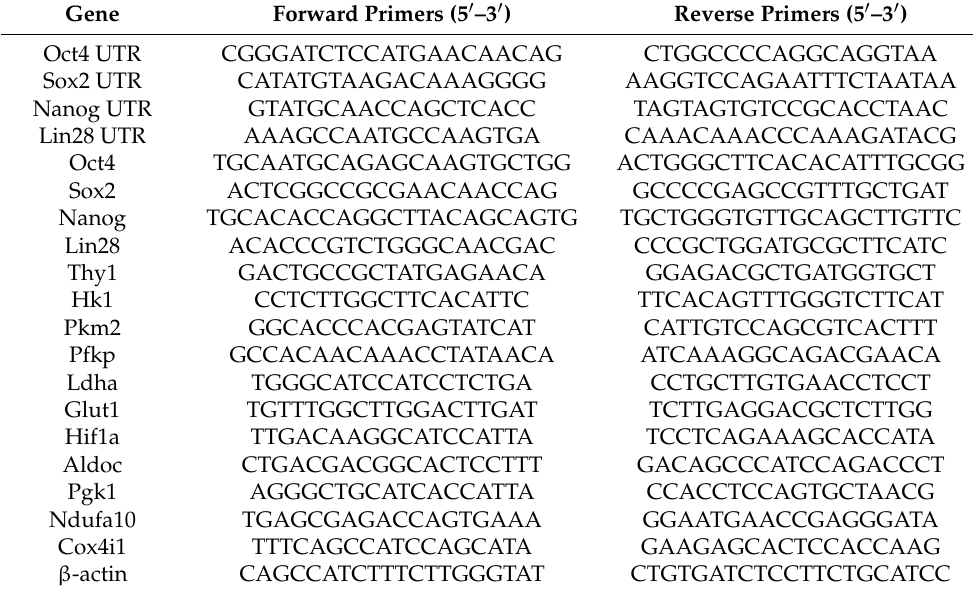
Table 1. Primers for